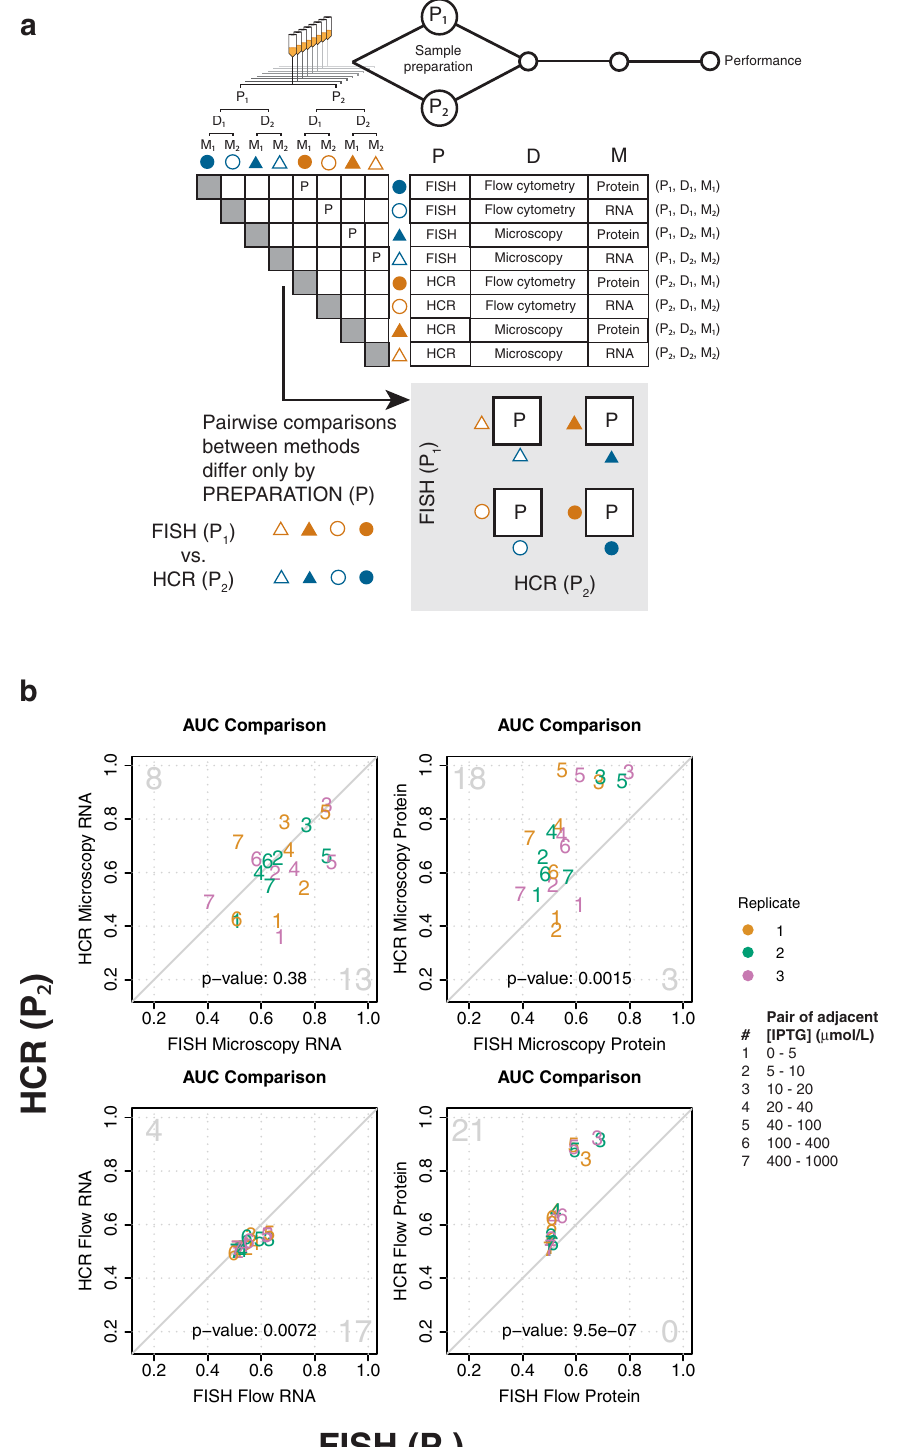
Fig. 5 Method performance can be attributed to sample preparation. a Pairwise comparisons of methods that share the same steps for signal detection and measurand, but differ in sample preparation (indicated by “ P ” in the matrix), are used to attribute measurement performance to sample preparation. The four boxes containing “ P ” under the matrix represent these same pairwise comparisons. b Pairwise AUC plots of measurements in ( a ) are used to compare resolvability between sample preparation methods (FISH versus HCR). Diagonal line indicates equivalent resolvability between the two methods. Pairs of adjacent IPTG concentrations are shown as numbers within the plots, as indicated in the fi gure legend. Color indicates biological replicates one (orange), two (green), and three (purple), as indicated in the fi gure legend. Large gray numbers in the top-left and bottom right-corners indicate how many AUC ’ s were higher for the method plotted on the y -axis or x -axis, respectively. The two-sided p -values for a sign test are shown within each